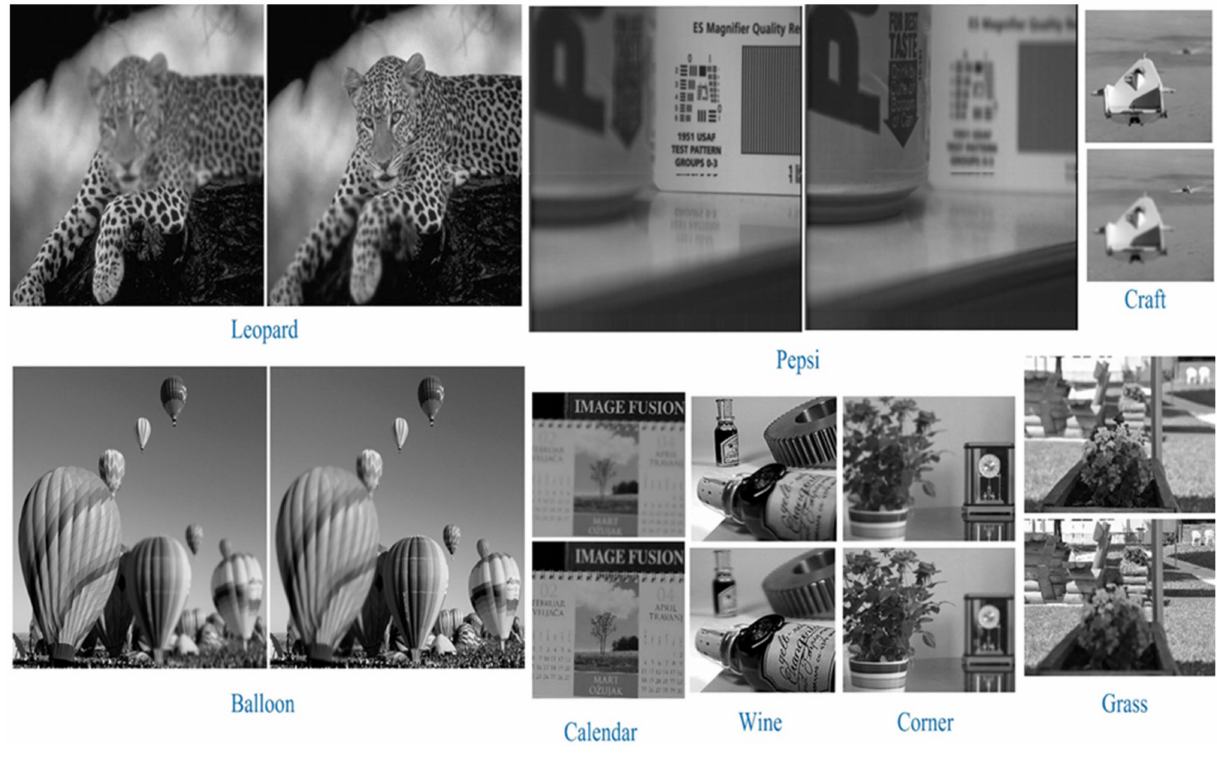
Figure 17. Some multi-focus image pairs.